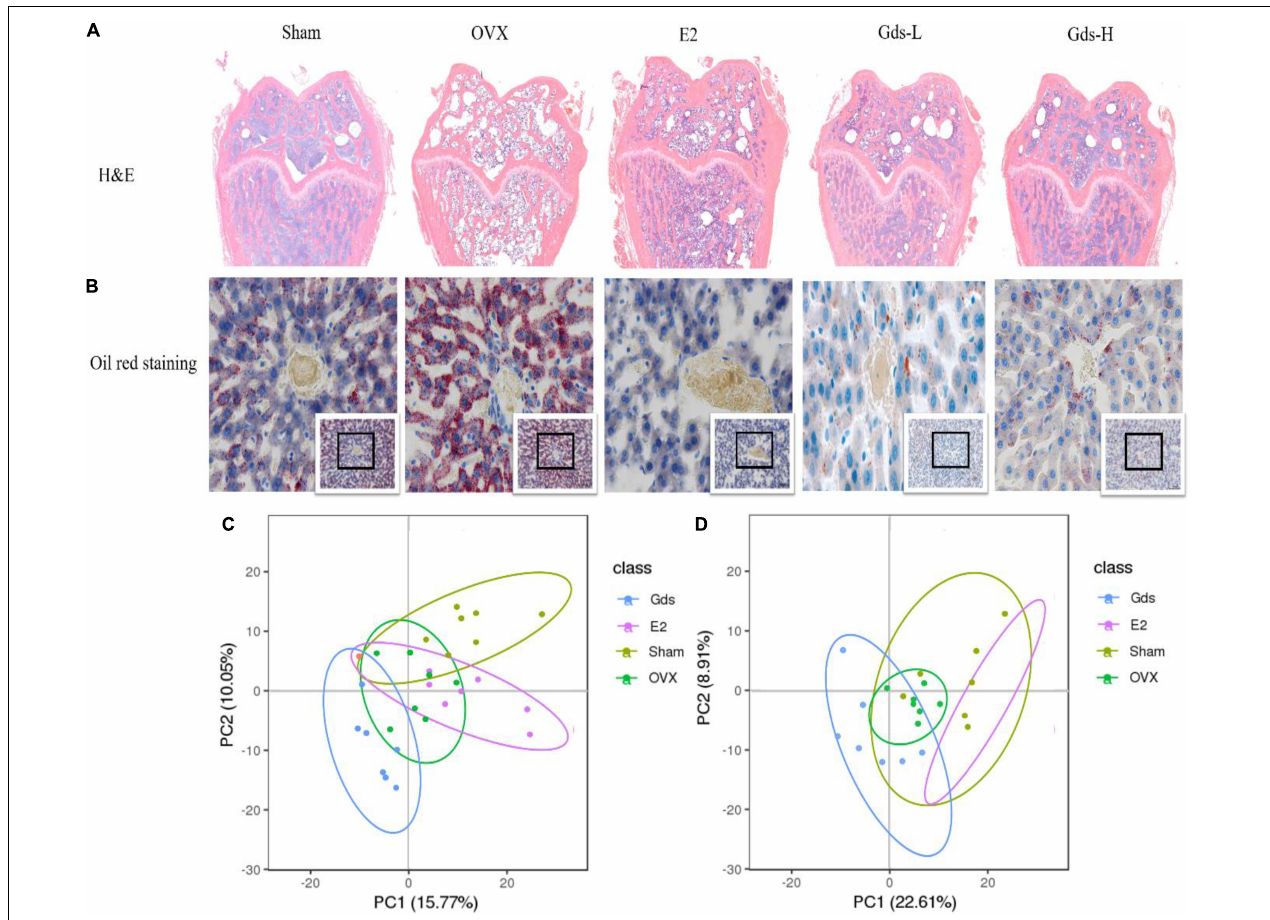
FIGURE 3 | Gds protected rats against fat anabolism leaded bone loss by regulating lipid metabolism. (A) Histological image of bone was displayed by H&E staining. (B) The lipid level of liver was showed by oil red staining. (C) The serum metabolism score plot of PCA for each group in positive ion mode. (D) The serum metabolism score plot of PCA for each group in positive ion mode. Sham, sham operated group; OVX, ovariectomized control group; Gds-L, low dose of Gadus morhua sialoglycoprotein-treated group; Gds-H, high dose of Gadus morhua sialoglycoprotein-treated group; E2, positive drug control group. TABLE 1 | Result of metabolite difference screening. Compared Num. of Total Num. of Total Num. of Sig. Num. of Sig. Samples Ident. Sig. Up